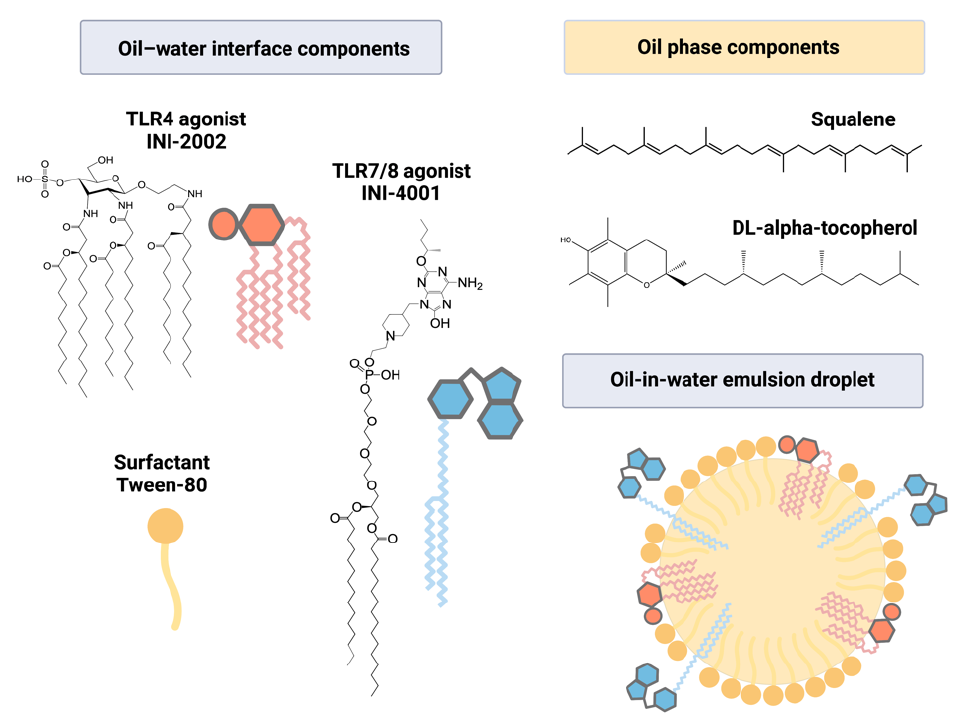
Figure 1. Structures of compounds incorporated in a squalene-based emulsion. INI-4001, a lipidated oxoadenine and TLR7/8 agonist, and/or INI-2002, a synthetic TLR4 agonist, were incorporated into an AddaS03-like emulsion. Lipid moieties present in the compounds allowed incorporation into the oil–water interface, along with the surfactant Tween-80. The oil phase was comprised of squalene and DL- α